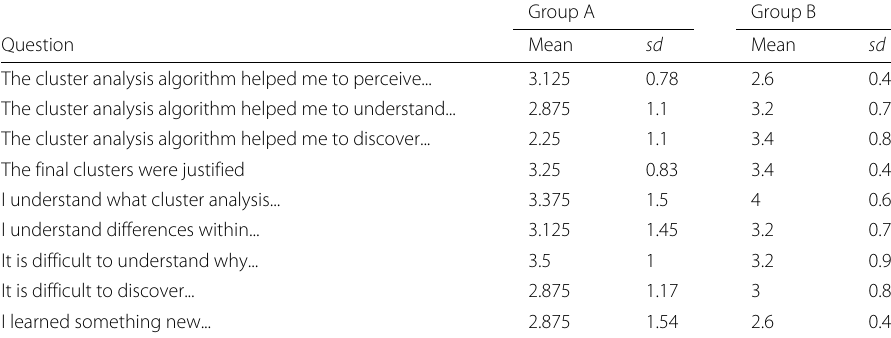
Table 4 Descriptive statistics of the questionnaire (scale 1-5) Group A Group B Question Mean sd Mean